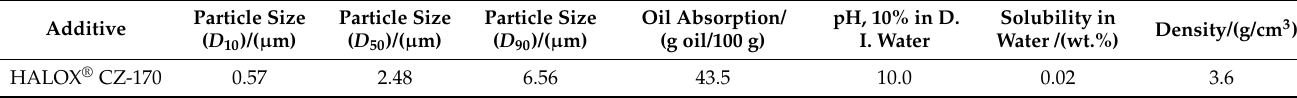
Table 1. Properties of the anti-corrosive additive HALOX